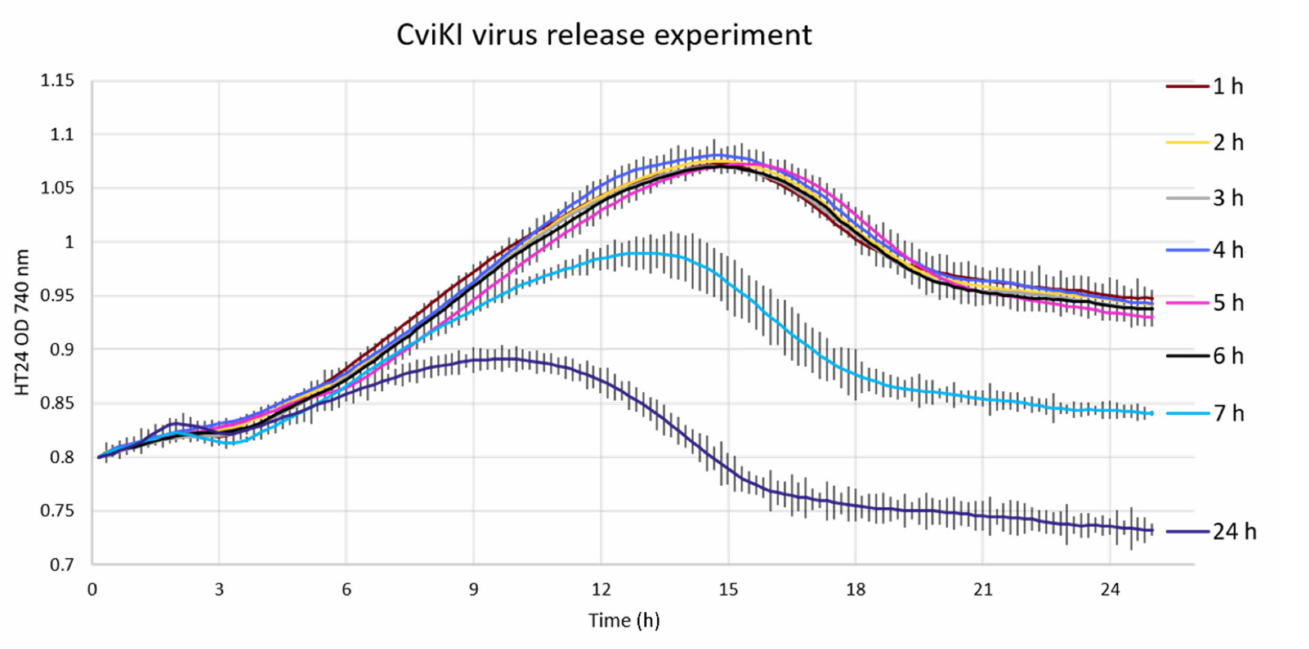
Figure 7. Infection of Chlorella variabilis cultures with filtered spent medium from previously infected cultures at 5 MOI with CviKI virus isolate sampled every hour up to 7 h p.i. and at 24 h p.i. The values are the average of 3 biological replicas with standard